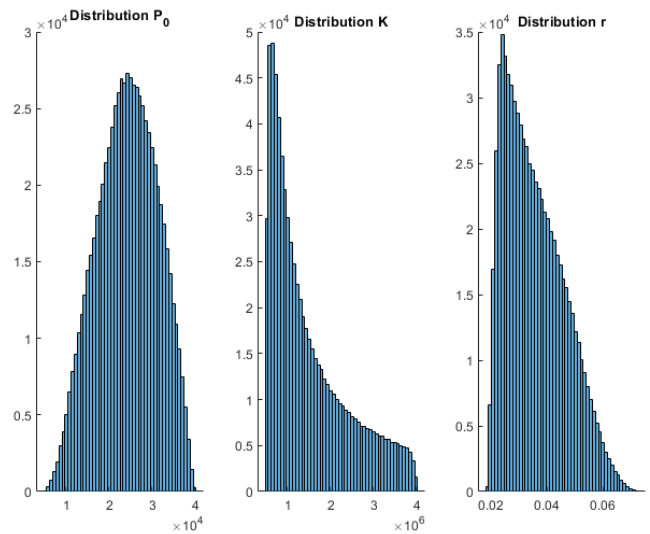
Figure A2. Histograms 5 January 2021 wave 3 Gompertz—Spain.